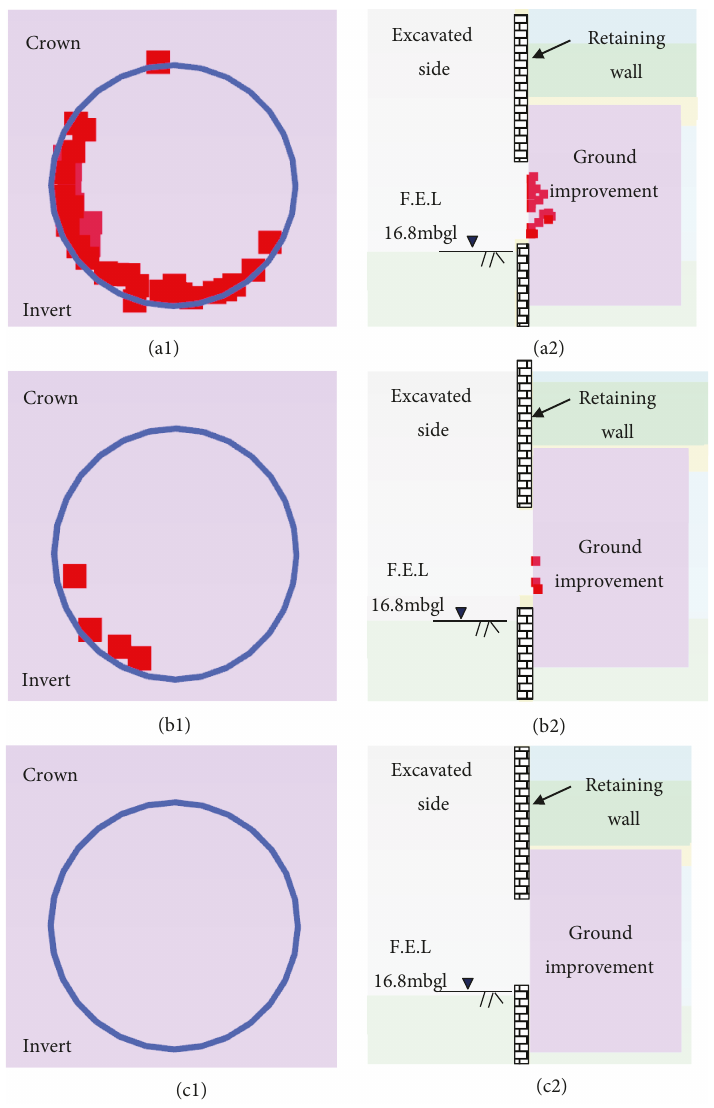
Figure 15: Impacts from various soil strength on failure caused by launching of a shield. Note: “ 1 ” means transverse direction and “ 2 ” means longitudinal direction. (a) 50 kPa (cohesion), (b) 100kPa (cohesion), and (c) 200kPa